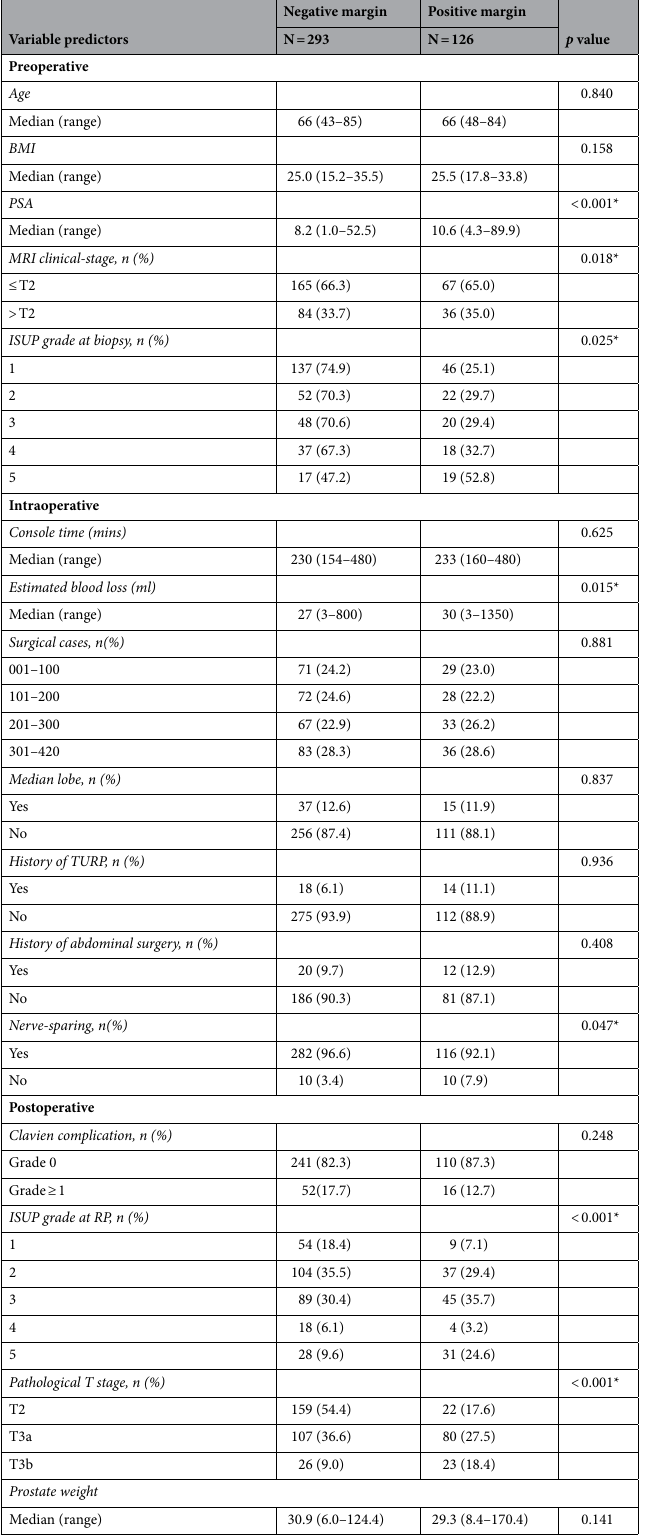
Table 2. Comparison of predictive characteristics between positive and negative surgical margins for 419 patients having undergone robotic prostatectomy. BMI body mass index, PSA prostate-specific antigen, MRI magnetic resonance imaging, ISUP International Society of Urological Pathology, RP radical prostatectomy, TURP transurethral resection of the prostate, * p value for difference between margins status < 0.05; statistical analysis, continuous data: t -test, categorical data: chi-square